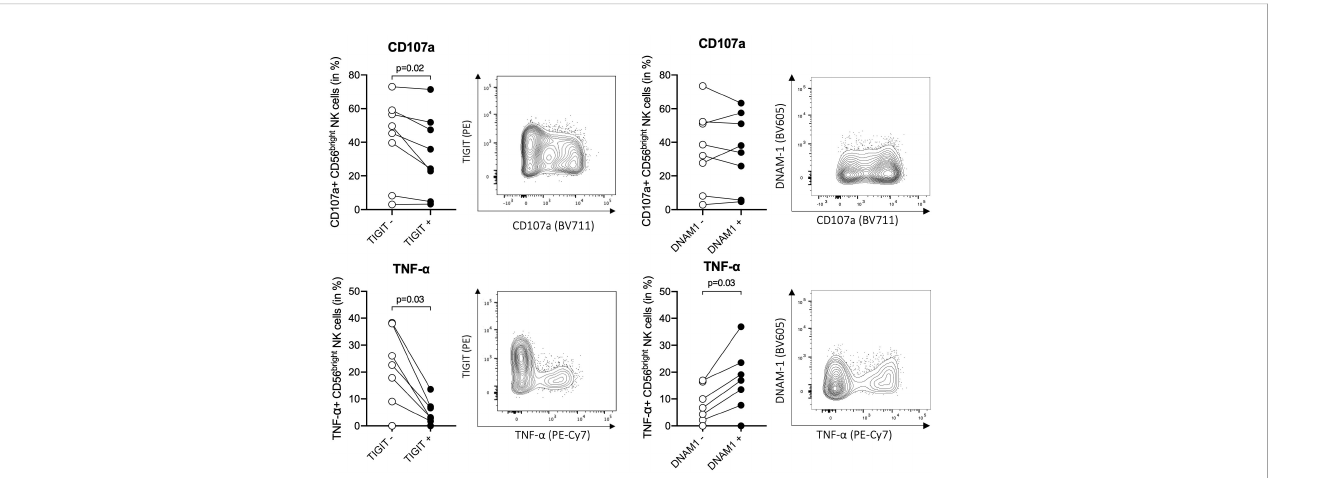
FIGURE 3 Functional activity of TIGIT +/ – and DNAM-1 +/ – cells. Functional responses of TIGIT +/ – and DNAM-1 +/ – CD56 bright ihNK cells, following co-incubation of liver-derived cells with K562 (E:T ratio of 10:1) for 5h at 37°C. Representative fl ow plots showing distribution of CD107a (top) and TNF- a (bottom) expression on CD56 bright ihNK cells depending on their TIGIT or DNAM-1 expression. Graphs on top showing percentage of CD107a + TIGIT +/ – or DNAM- 1 +/ – CD56 bright ihNK cells and graphs below showing percentage of TNF- a + TIGIT +/ – or DNAM-1 +/ – CD56 bright ihNK cells. Wilcoxon matched-pairs sign rank test was used to determine statistical differences. Each dot represents one donor